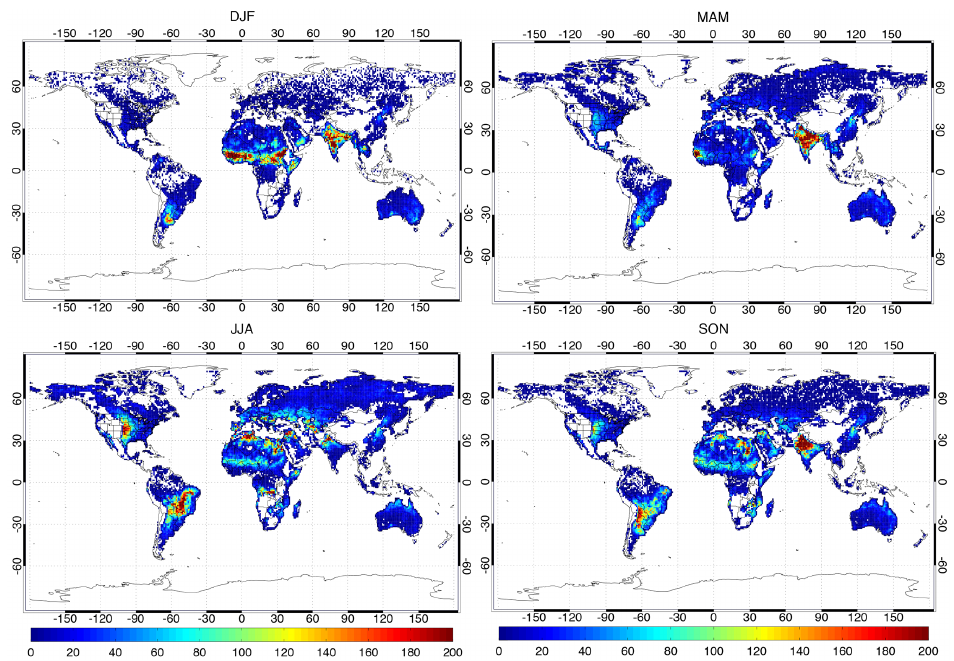
Figure 8. As in Fig. 7 except for the occurrences of high concentrations (VMRs ≥ 1ppbv). Red/blue colors indicate relatively high/low occurrences of high